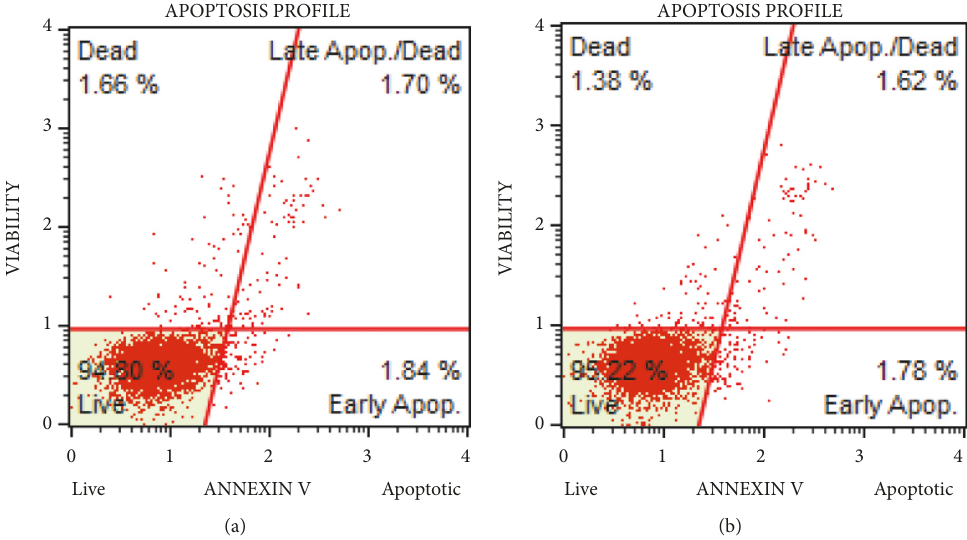
Figure 4: Annexin V Assay confirms diCQA does not induce apoptosis in DU-145 cells . The MUSE Annexin assay for the control cells (a) and cells treated with 5 𝜇 M (IC 50 ) of 4,5-diCQA for 72 hours (b).